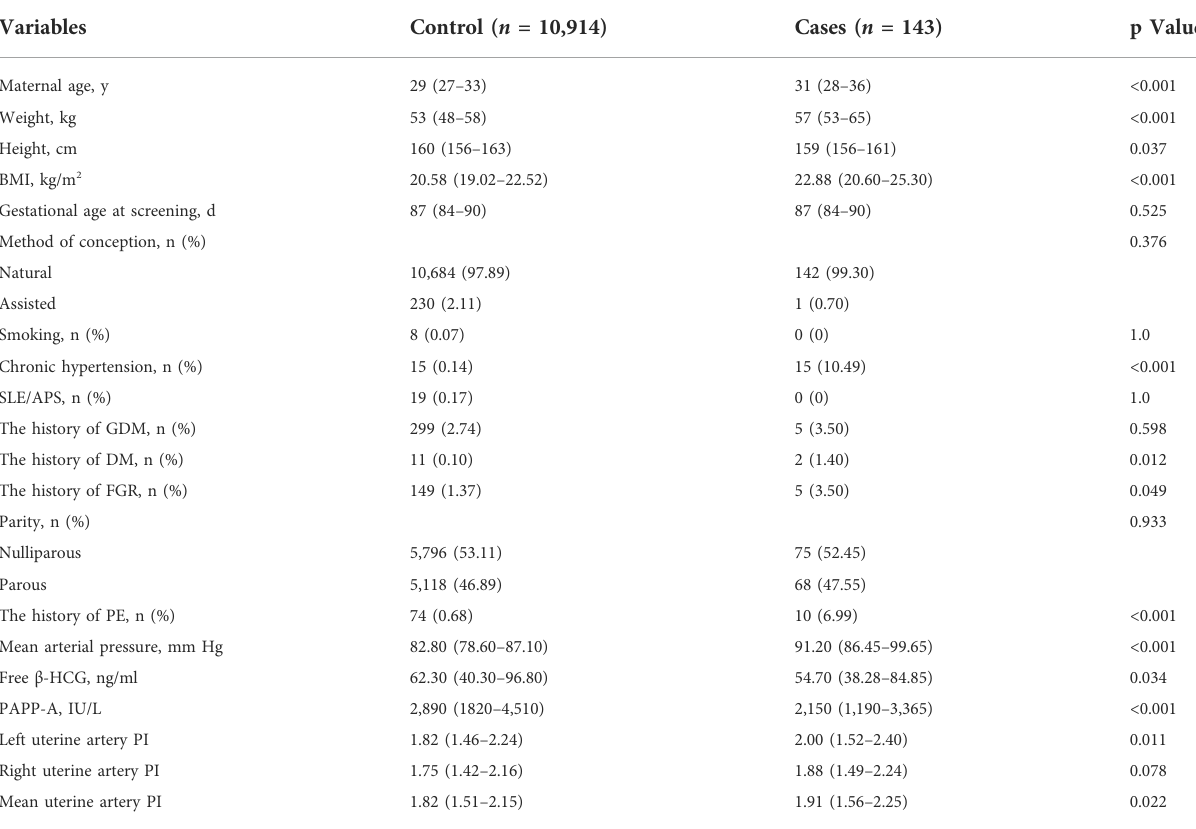
TABLE 1 Demographic and clinical characteristics of the study population.